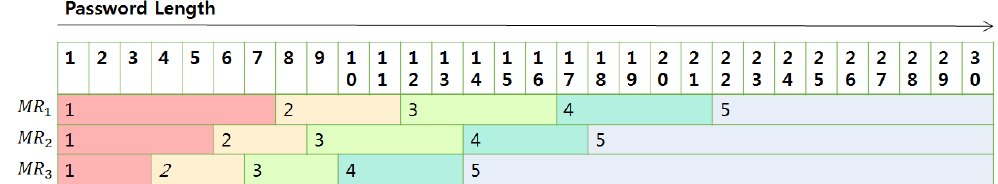
Figure 9. The content of length-strength matching tables; The red color is dangerous and the stronger the password goes to the